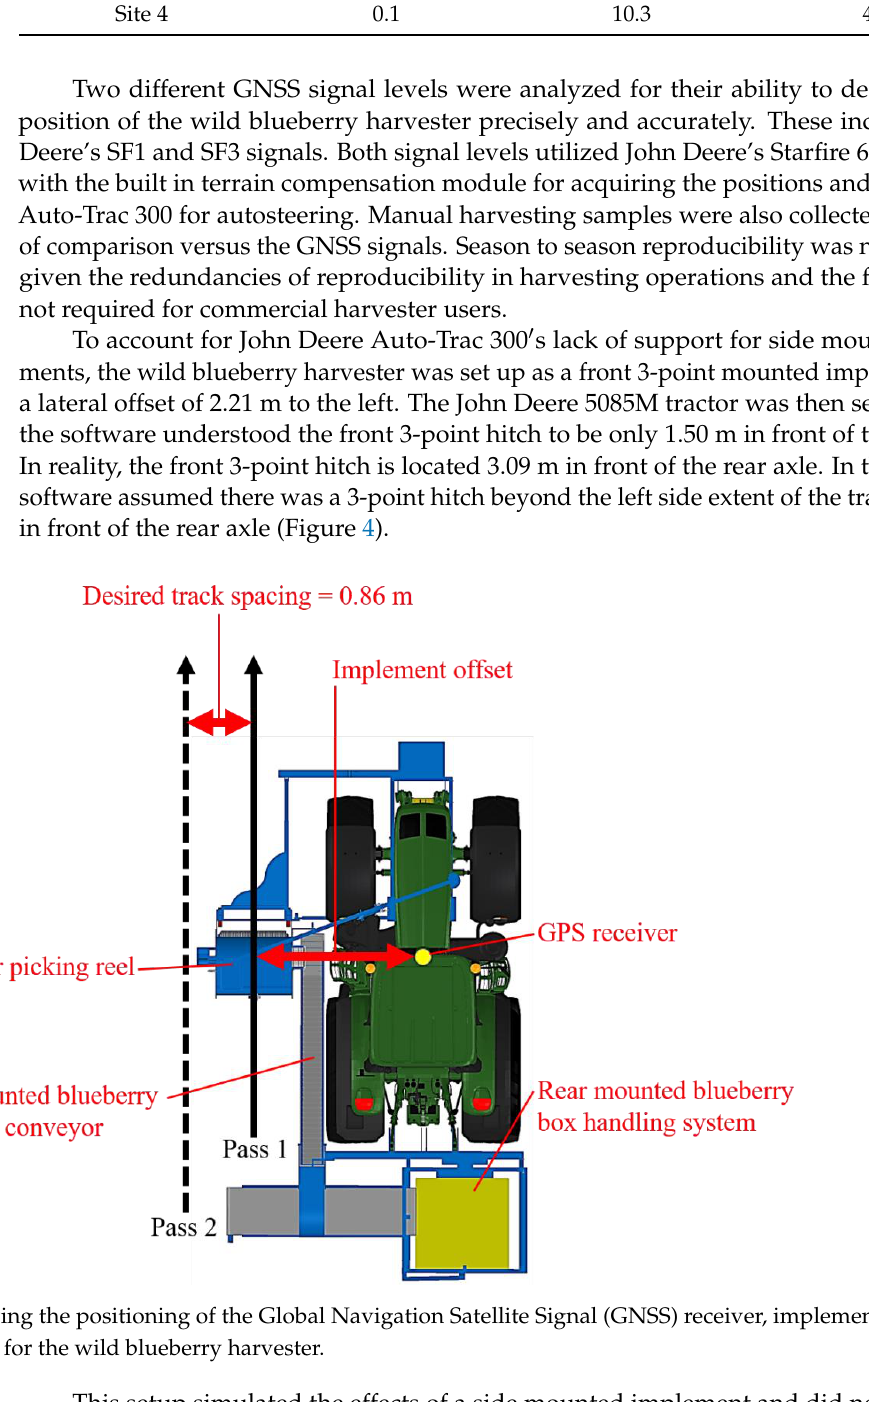
Table 2. Minimum, maximum, and mean field slopes for each of the harvested sites.